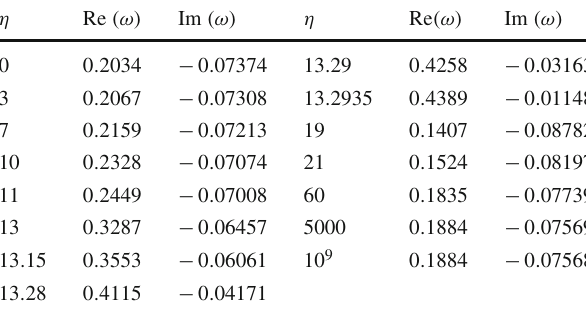
Table 5 Fundamental quasinormal modes for non-minimally coupled scalarfieldevolvinginRNdSblackholeswithvarying η .Thespacetime parameters read M = L / 7 = (cid:2) = 2 Q = 1 and m 2 =